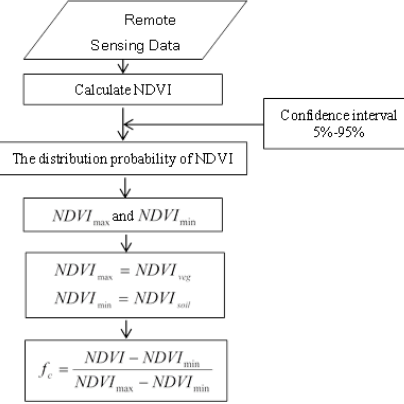
Figure 3. Pixel dichotomy calculation flow chart